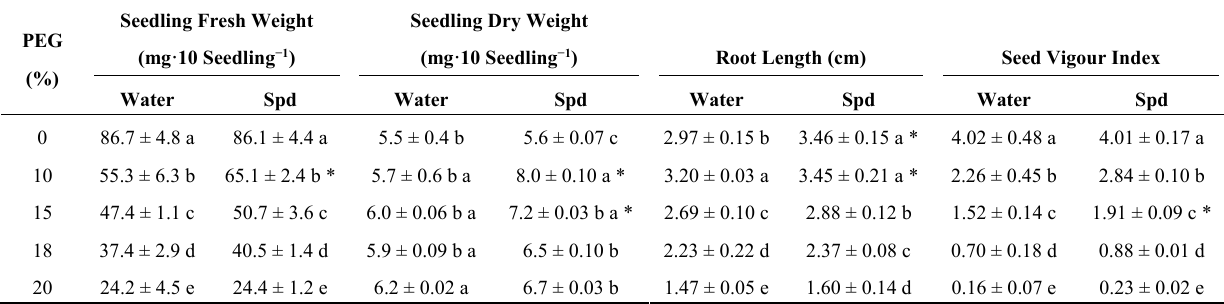
Table 2. The effect of seed priming with water or spermidine (Spd) on fresh weight, dry weight, root length and seed vigour index in seeds of white clover after 7 days of germination under different water stress. Values are mean ± SE ( n = 6). Different letters in a vertical column indicate a significant difference in each treatment under different PEG concentration conditions. The asterisk indicates a significant difference exists between seed priming with water or Spd. LSD ( p ≤